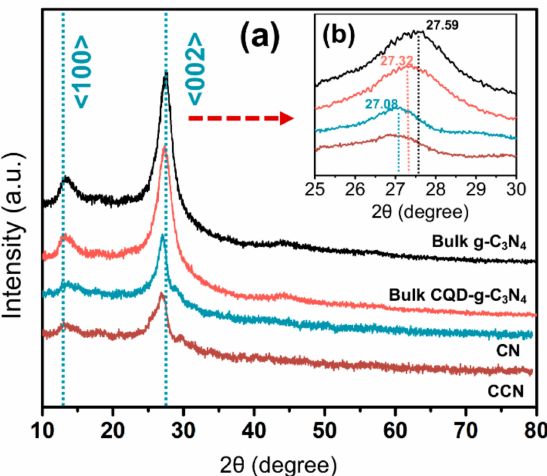
Figure 2. X-ray di ff raction (XRD) patterns of the bulk g-C 3 N 4 , bulk CQDs-g-C 3 N 4 , CN, and CCN ( a ); and enlarged view of the 25 ◦ to 30 ◦ region ( b